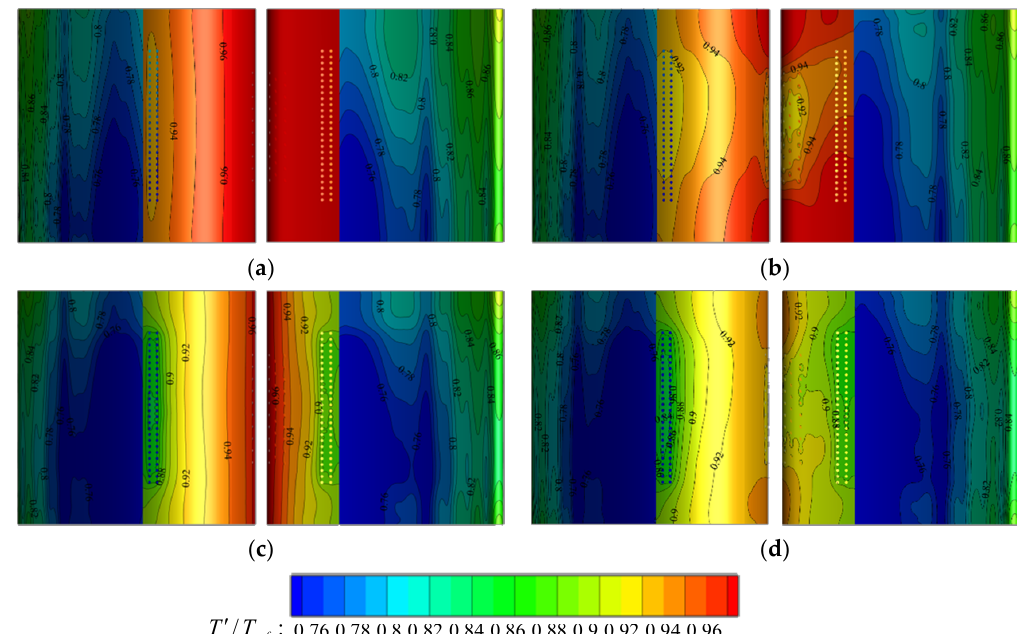
Figure 11. Substrate temperature comparisons for di ff erent cases. ( T ref = 701 K). ( a ) uncoated vane without film, ( b ) uncoated vane with LE film, ( c ) uncoated vane with downstream film, ( d ) uncoated vane with LE and downstream